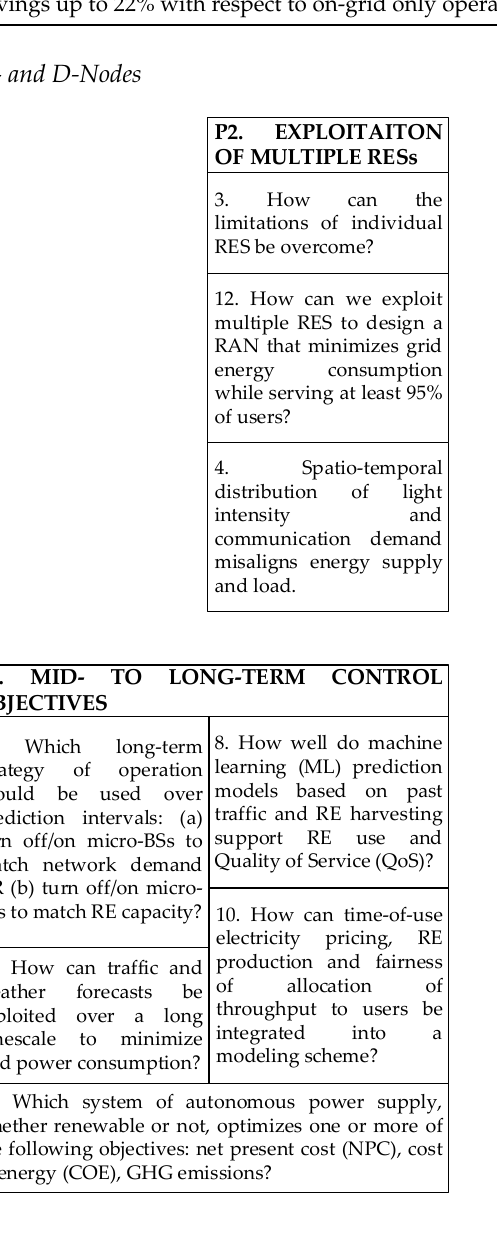
Table A3. Cont. Development # Development Code MPC for predictive, long timescale control, using 0- (reactive), 1- and 5-h 30 [150] prediction horizons. Comparison: MPC vs on-grid only operation: Energy consumption: reduced 31 [150] by 13.1%. Infrastructure dimensioning: optimal storage capacity can be determined 32 [150] and enables savings up to 22% with respect to on-grid only operation.